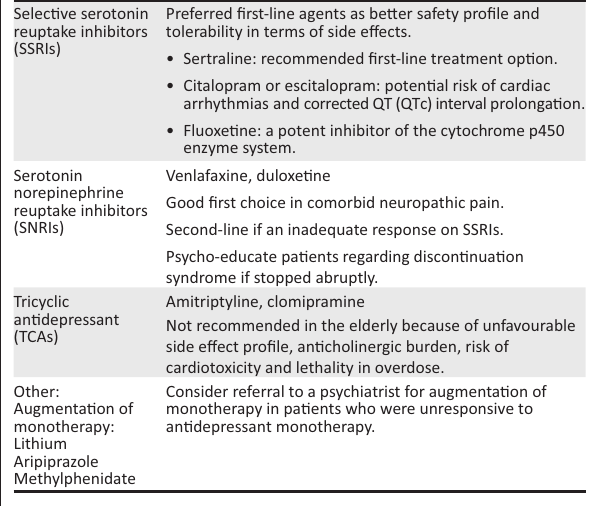
FIGURE 2: Prescribing of specific psychotropic